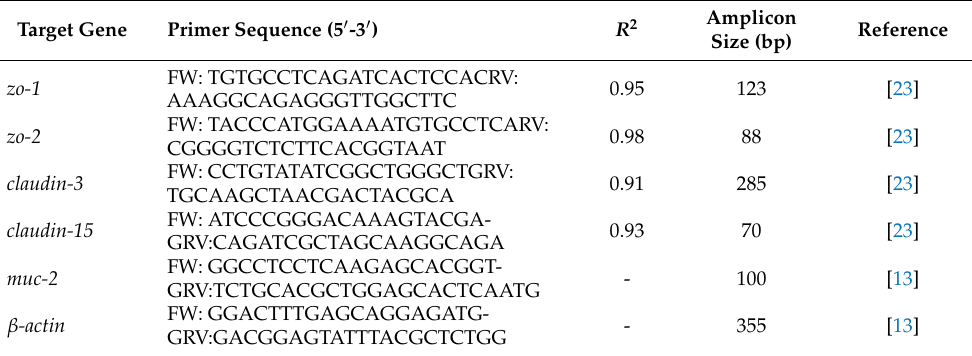
Table 2. Primers used to quantify the expression of genes related to the intestinal barrier of A . tropicus larvae.